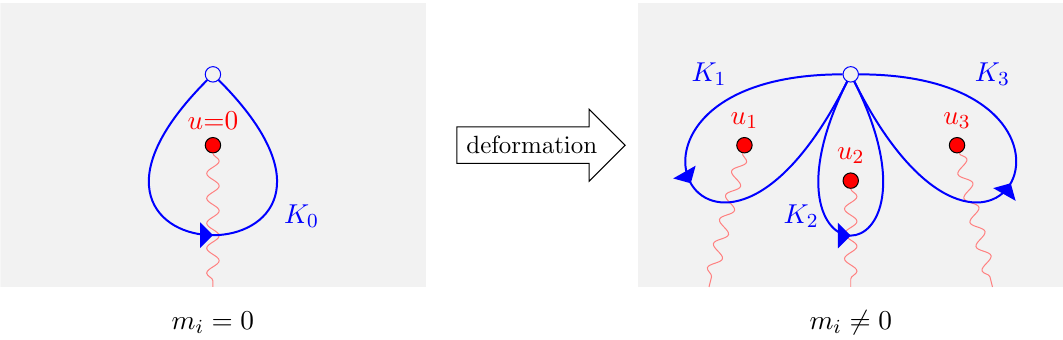
Figure 1 . Singularities and their monodromies on the u -plane without ( m i = 0) and with ( m i 6 = 0) generic mass deformation. The solid points with coordinates u a are the singularities shown with a choice of \branch cuts" emanating from them. The K a 2 SL(2 ; Z ) are EM duality monodromies associated to the closed paths looping around these singularities starting from a conventional base point given by the open